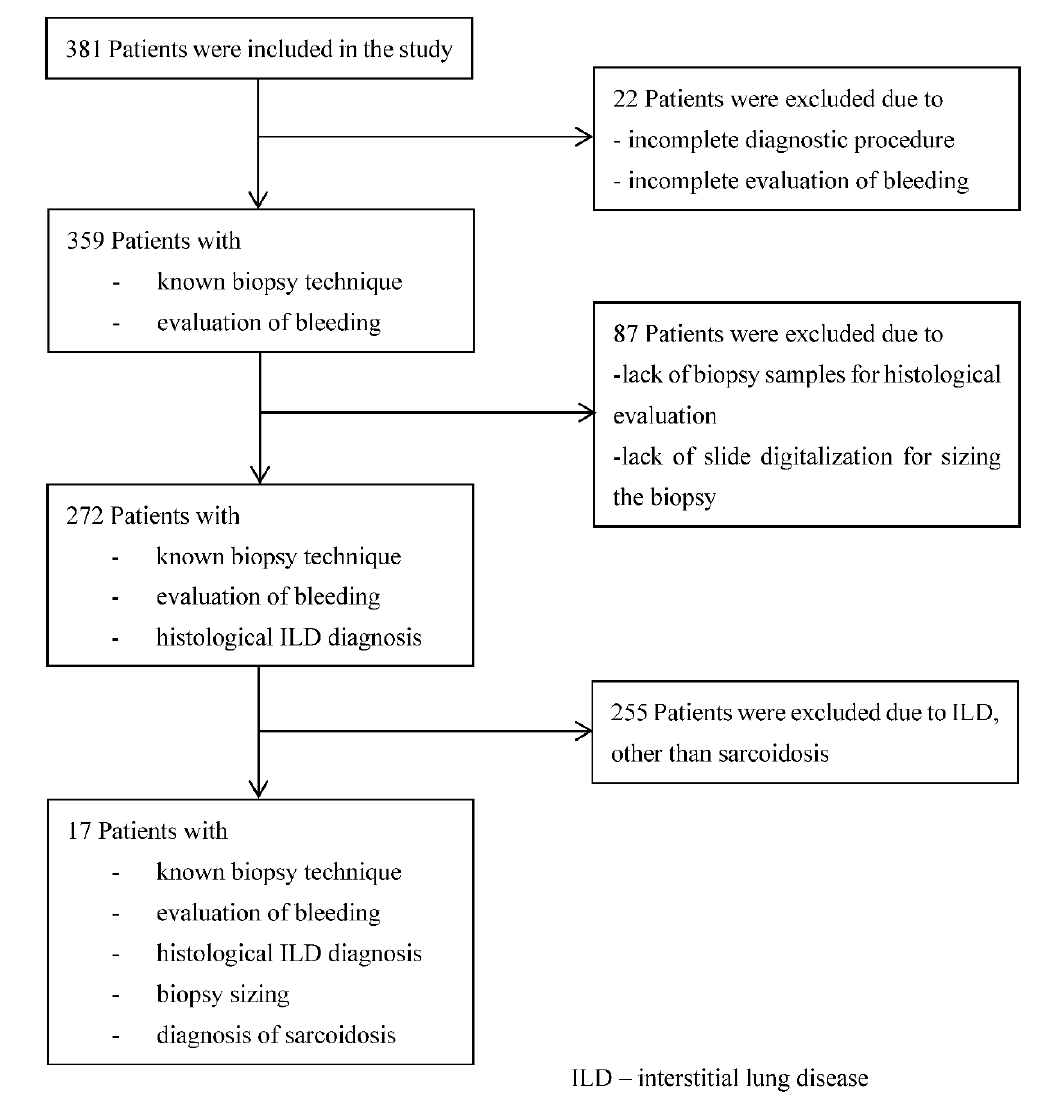
Figure 2. Study Figure 2. Study population .